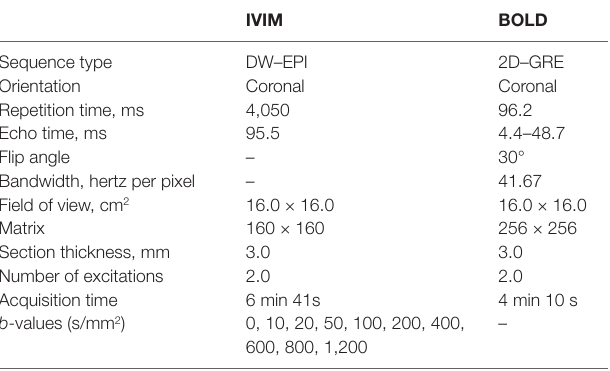
MRI, magnetic resonance imaging; IVIM, intravoxel incoherent motion; BOLD, blood oxygenation level–dependent; DW–EPI, diffusion-weighted echo-planar imaging; 2D-GRE, two-dimensional gradient-recalled